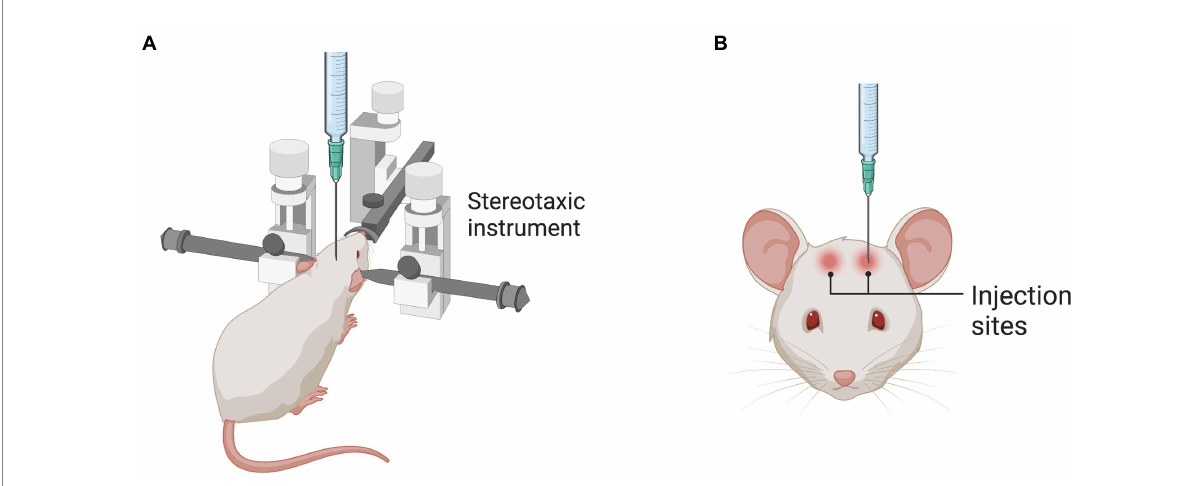
FIGURE 1 Stereotaxic injection into the rodent brain. (A) The illustration shows the stereotaxic instrument used to locate the specific brain regions. (B) The illustration shows the injection sites in the brain as an